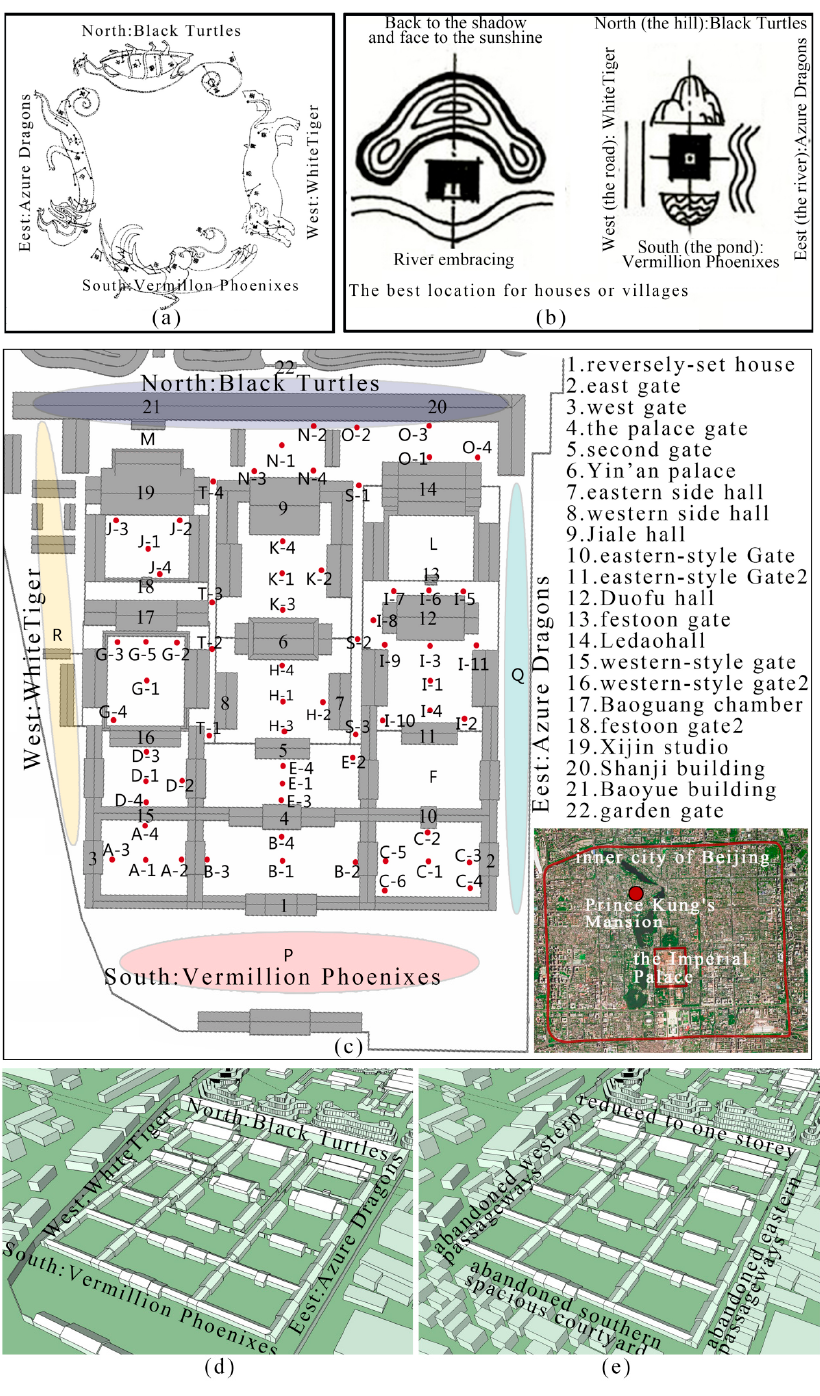
Figure 1. ( a ) The 28-star chart depicting the Four Emblems; ( b ) the Form School feng shui layout in ancient China; ( c ) the Form School feng shui layout of Prince Kung’s Mansion; ( d ) the feng shui layout; ( e ) the dissimilation layout.